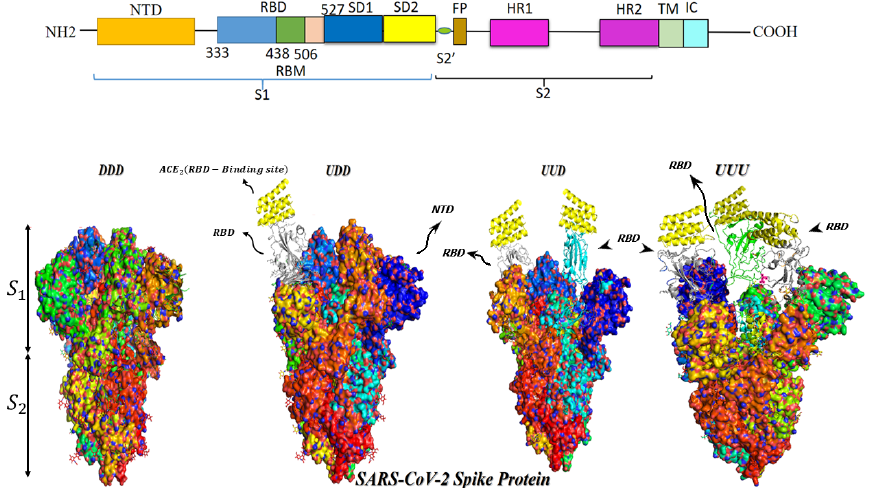
Figure 2. Linear representation of different domains of monomeric S protein and “open, U” and “closed, D” conformations of S protein. The defining of the boundary of S1 and S2 subdomains (arrows on the left side) is just a simplification (see Figure 1). Sequential opening of RBDs of the trimeric S protein after docking of the first open RBD to ACE2 is displayed. It results in an untwisting movement of the monomers away from each other after binding of each “U” RBD to ACE2 (see the text). Green helices at the top of S protein represents RBD ‐ binding site of ACE2. NTD: N ‐ termi ‐